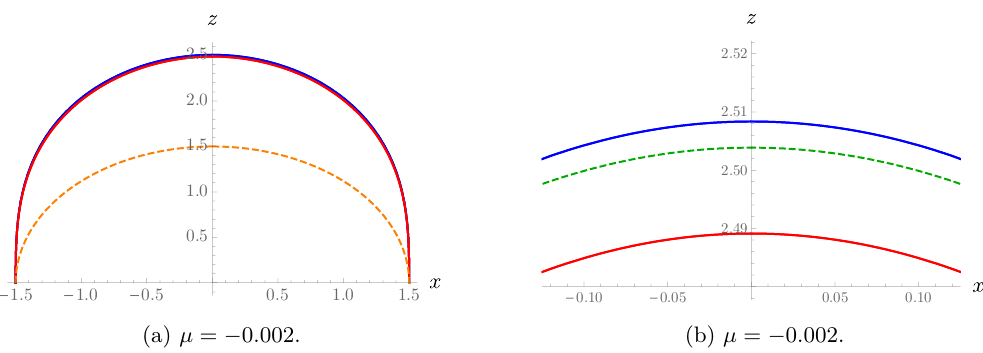
Figure 2 . Causal wedge (orange, dashed) and entanglement surfaces corresponding to ECG in the case of minimal prescription (blue), ECG in the case of non-minimal prescription (red), and Einstein gravity (green, dashed) [35] for ‘ = 3 and µ = − 0 . 002 , a value within the interval − 0 . 00322 ≤ µ ≤ 0 . 00312 . We include a close-up of the entanglement surfaces near x = 0 to tell them apart better.